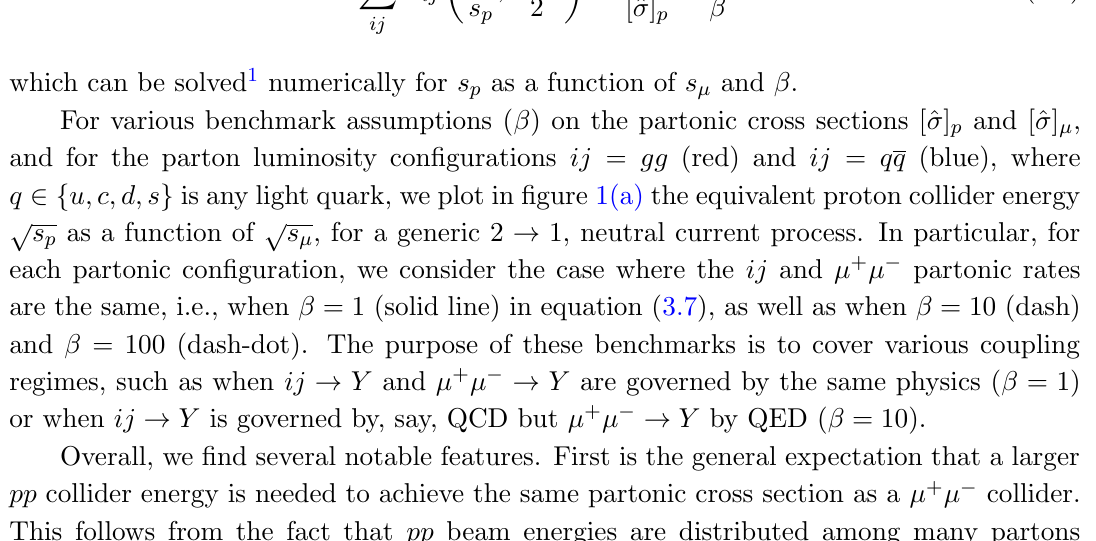
Figure 1 . The equivalent proton collider energy cross section as a (cid:22) + (cid:22) (cid:0) collider with energy process, for benchmark scaling relationships between the parton-level cross sections [^ (cid:27) ] p and [^ (cid:27) ]